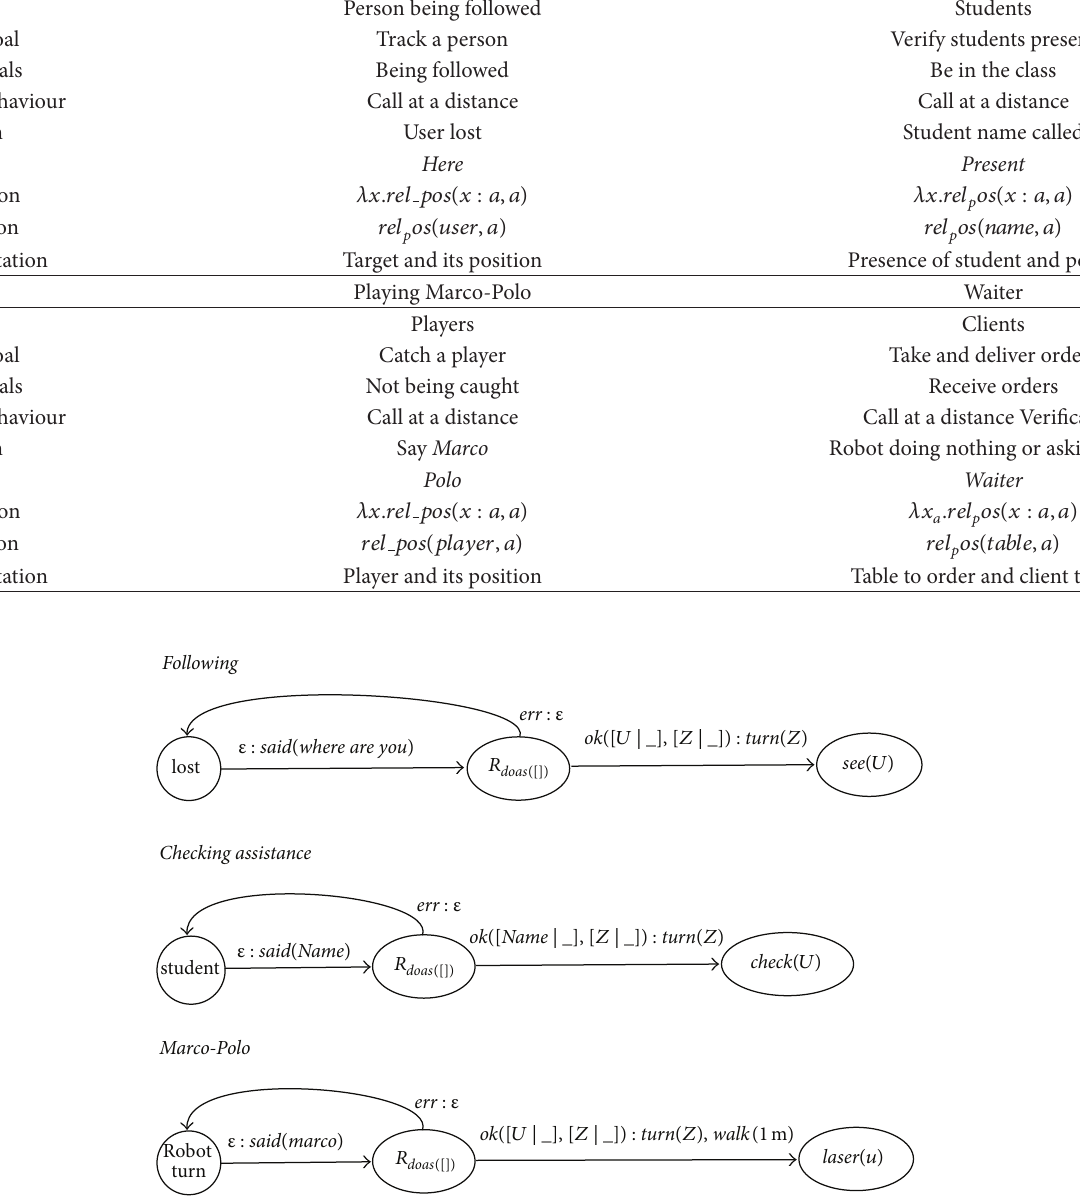
Figure 11: The DOA behaviour used on the following a person , taking attendance , and playing Marco-Polo